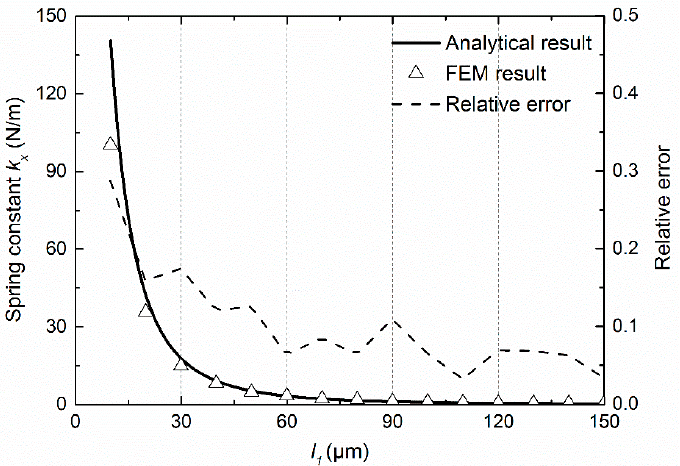
Figure 8. Curves of spring constant along the x -axis as a function of l 1 by both analytical calculation and finite element modelling (FEM) simulation along with the relative error as a function of l 1 , which is defined by ( k FEM − k anal )/ k FEM . Solid lines represent the approximate analytical results, triangles represent FEM simulation results, and dashed lines represent the relative errors. Red, black, and blue denote w = t = 0.5, 1, and 2 μ m, respectively.